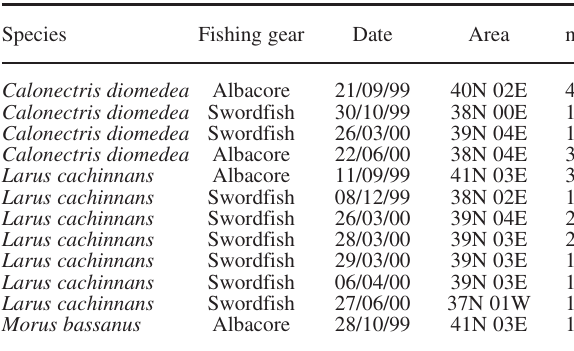
T ABLE 3. – Date and geographical position of the bycatches. The study area was subdivided into squares of 1X1 degree (Latitude-